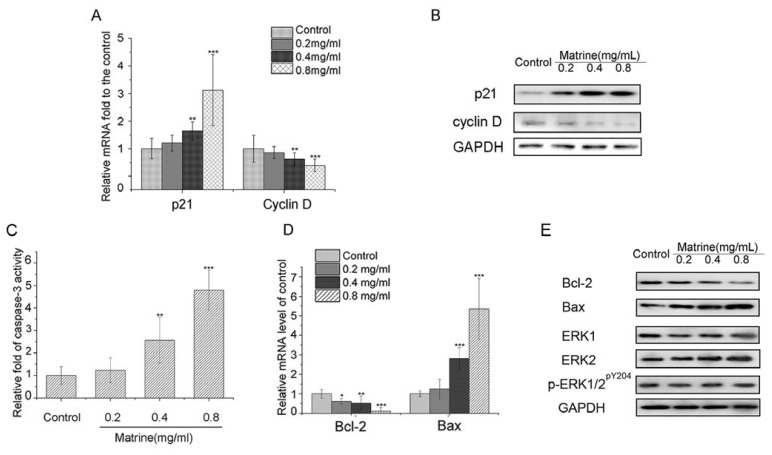
(A) Relative mRNA level of p21 and Cyclin D in M21cells with Matrine treatment at concentration as indicated; (B) Protein expression of p21 and Cyclin D in M21cells with Matrine treatment at concentration as indicated; (C) Relative activity of caspases activity. Cells were incubated with Matrine at concentration, as indicated for 48 h before the activity was tested; (D) Relative mRNA level of Bcl-2 and Bax in M21cells with Matrine treatment at concentration as indicated; (E) Protein expression of Bcl-2, Bax, ERK1, ERK2 and p-ERK1/2pY204 in M21cells with Matrine treatment at concentration as indicated. Cells were incubated with Matrine at concentration as indicated for 48 h before performing Western blotting and real-time PCR. All data were expressed as means ± SD of three separate experiments. Significantly differences from control were indicated as *p < 0.05; **p < 0.01; ***p < 0.001.